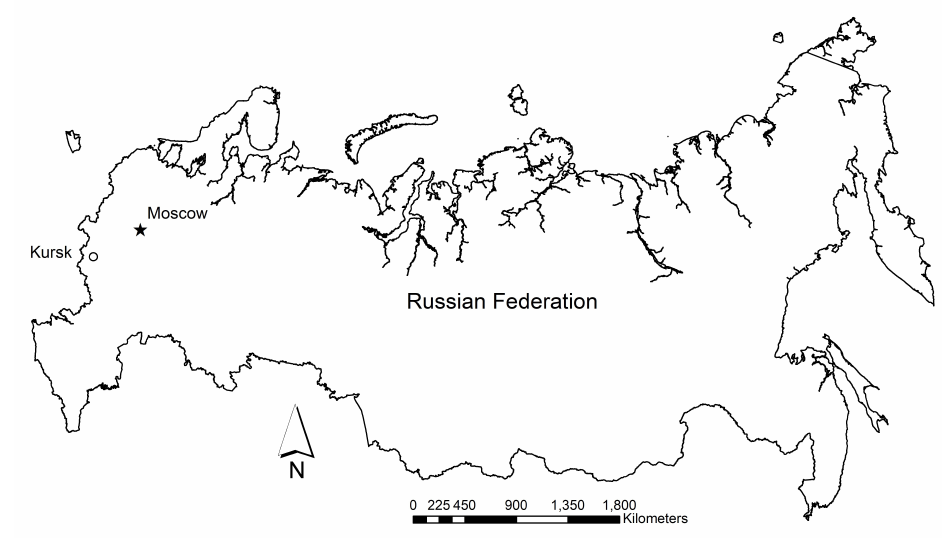
Figure 1. Location of the study